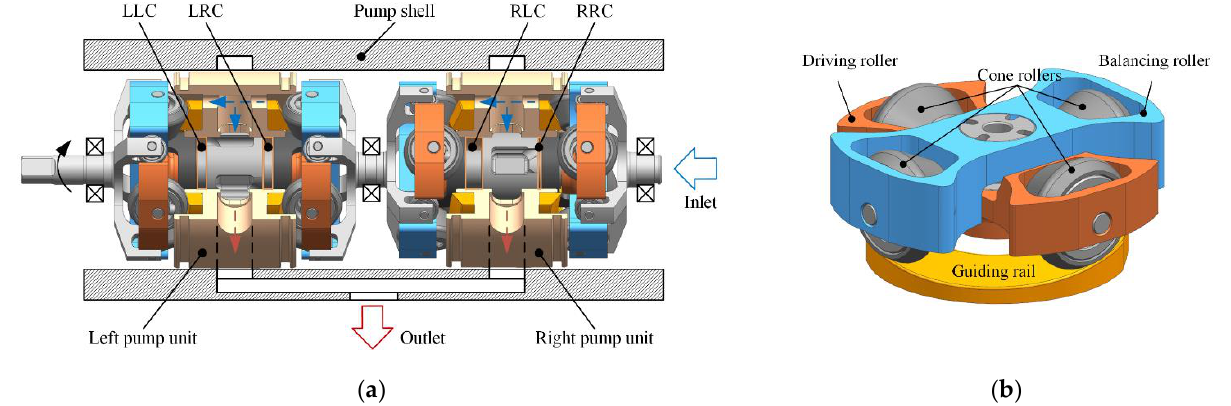
Figure 1. ( a ) The mechanical design of a parallel 2D piston pump and ( b ) working principle of the rollers and the guiding rail.